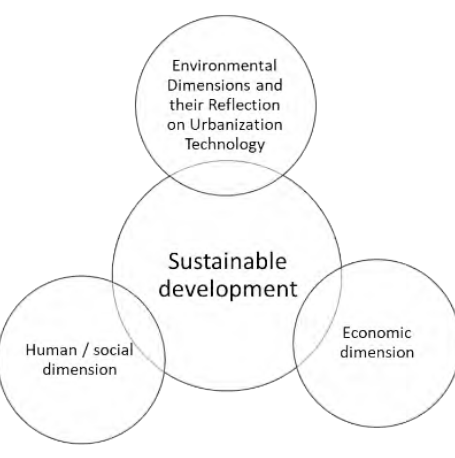
Figure 2. (Sustainable development Dimensions)